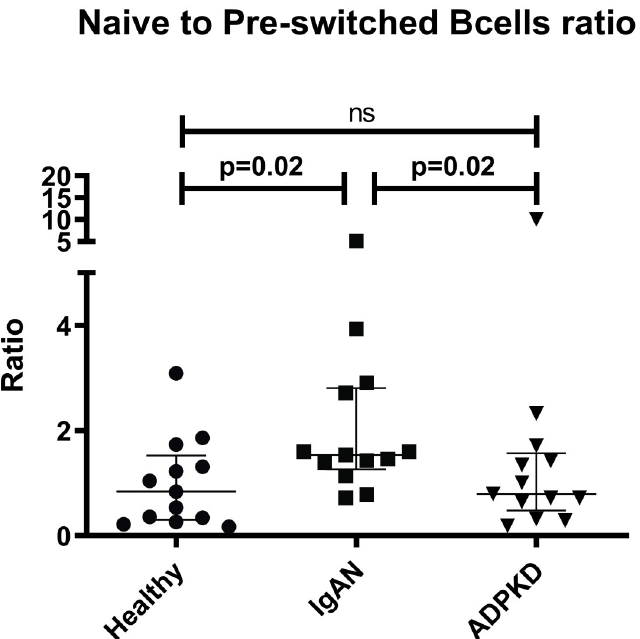
Fig 3. Ratio of na ï ve/pre-switched B cells. Ratio of na ï ve/pre-switched B cells in patients with IgA nephropathy (IgAN), autosomal dominant polycystic kidney disease (ADPKD) and healthy controls (HC). Comparisons for cell fractions were performed using the Kruskal-Wallis test, P < 0.05 was considered statistically significant. Scatter plots represent the range with whiskers and the median as the middle line.